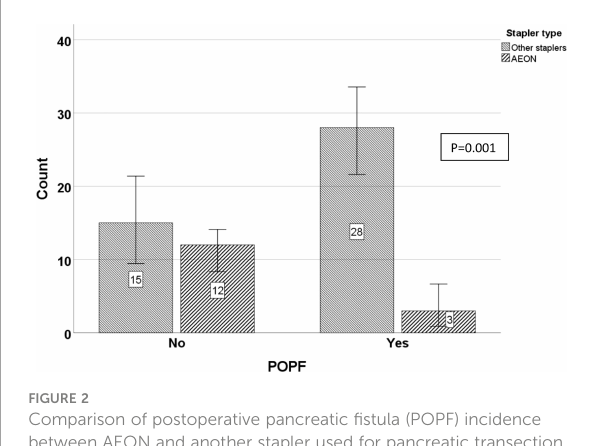
FIGURE 2 Comparison of postoperative pancreatic fi stula (POPF) incidence between AEON and another stapler used for pancreatic transection. Using the AEON stapler, the pancreatic leak rate was signi fi cantly lower when using AEON stapler (p = 0.001). All in the AEON group were A; in another stapler, all were A, save one which was a C.